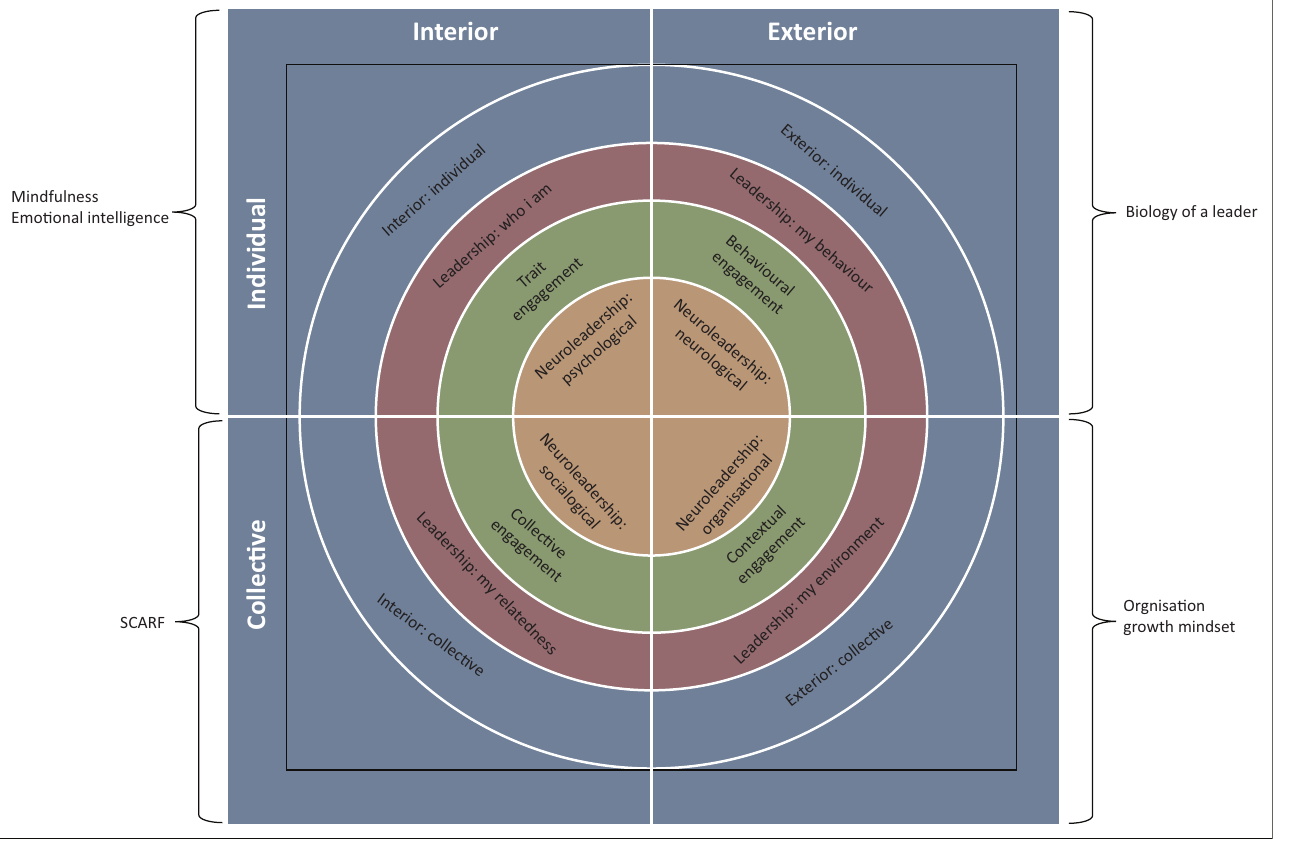
FIGURE 1: EngageInMind